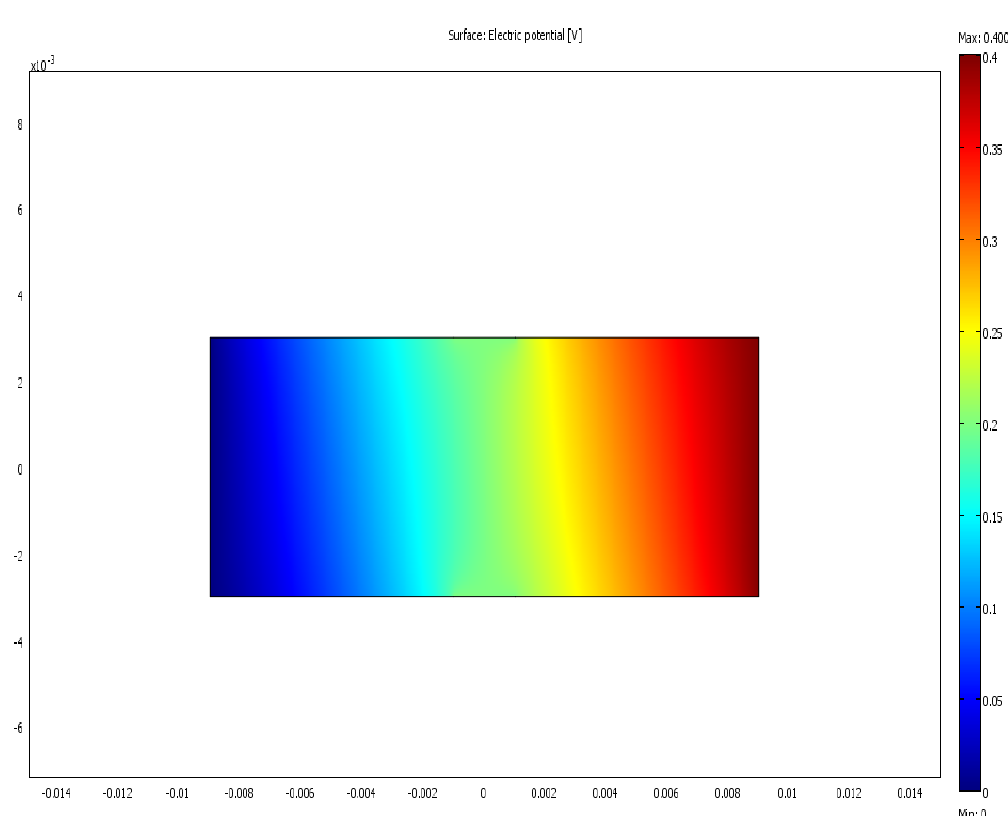
Figure 15. Top view of Hall’s voltage